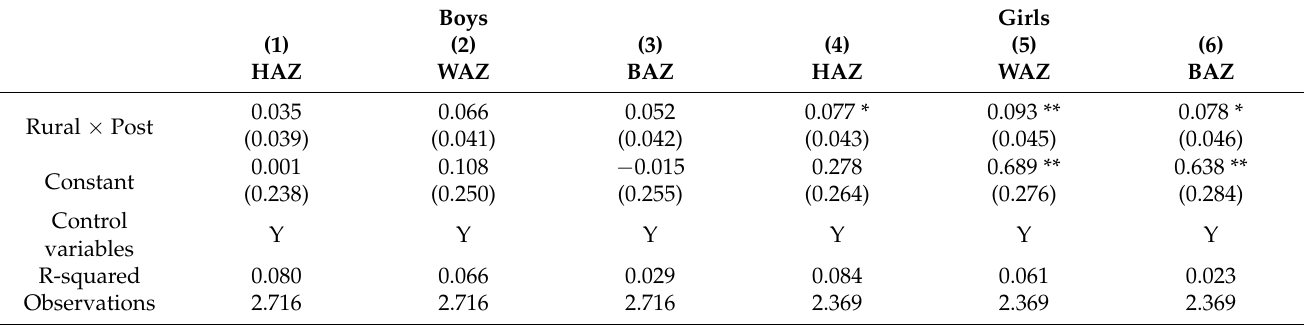
Table 5. Household technology and child health status: gender heterogeneity.